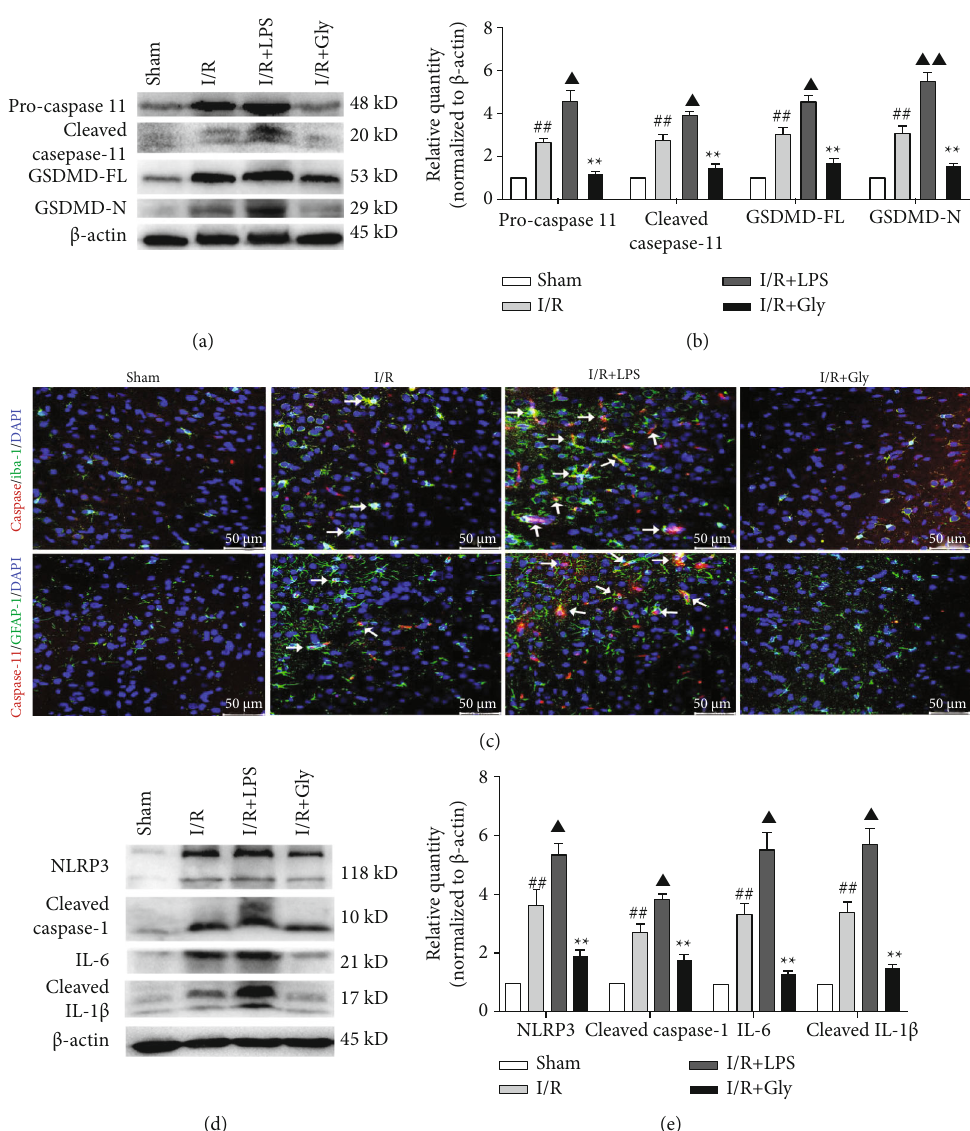
Figure 3: E ff ects of LPS and Gly interventions on expression levels of pyroptosis-related proteins and observations of pyroptosis locations. (a, b) Expression levels of pro-/cleaved caspase-11 and GSDMD-FL/N by Western blotting analysis, n = 6 . (c) Representative pictures of the double immuno fl uorescence staining (white arrows) of caspase-11 (red) colocalized with Iba-1 or GFAP (green), respectively, scale bars, 50 μ m. (d, e) Expression levels of NLRP3, cleaved caspase-1, IL-6, and cleaved IL-1 β , n = 6 . Data are presented as mean ± SD . ## P < 0 : 01 , I/R group versus sham group; ▲ P < 0 : 05 , ▲▲ P < 0 : 01 , I/R +LPS group versus I/R group; ∗∗ P < 0 : 01 , I/R + Gly group versus I/R